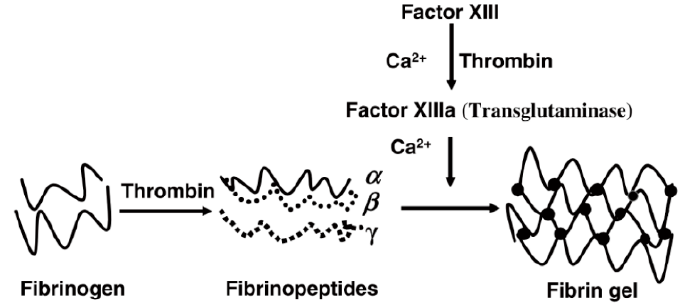
Figure 3. The process of fibrin gel formation through the reaction of fibrinogen and thrombin. Reprinted from [45]. Copyright (2008) IOP Publishing.